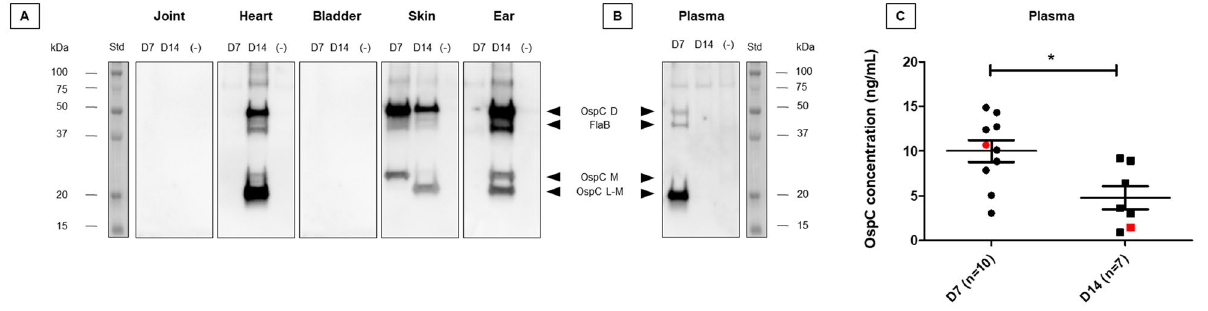
Figure 5. Analysis of tissue extracts from experimentally infected mice. ( A ) Western blot analysis of FlaB and OspC extracted from tissues of mice infected by the Borrelia BO23 strain. After immune-concentration of FlaB and OspC from tissue extracts, proteins were analyzed by western blot using a mix of biotinylated FlaB-15 and C10-11 mAbs. Data shown are representative of five mice (at 7 or 14 days). The analysis of non-infected mouse samples are included as negative controls (−). ( B ) Similarly, western blot analysis was performed with samples of plasma from infected and non-infected mice. ( C ) The graph represents the measurement by SPIE-IA of OspC in plasma of infected mice at 7 days (ten samples) and 14 days (seven samples). The statistical analysis was performed using the nonparametric Mann–Whitney U test * p < 0.05. The red dot and red square on the graph indicate plasma samples analyzed by western blot in which the amount of OspC in plasma was determined by quantitative SPIE-IA of C10 peptide. Std: Molecular weight markers and protein sizes (kDa) are indicated on the side of the gel. D dimer, M monomer, L-M low monomer. Uncropped original images are reported in Fig. S3.